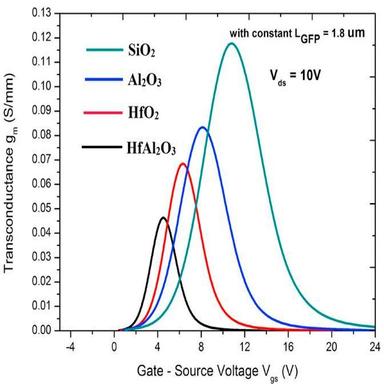
Transconductance (gm) as a function of gate source Voltage (gm-Vgs) characteristics for Quaternary barrier material (QB-MIS-HEMT) with different dielectrics and constant gate field plate (LGFP) of 1.8 μm.